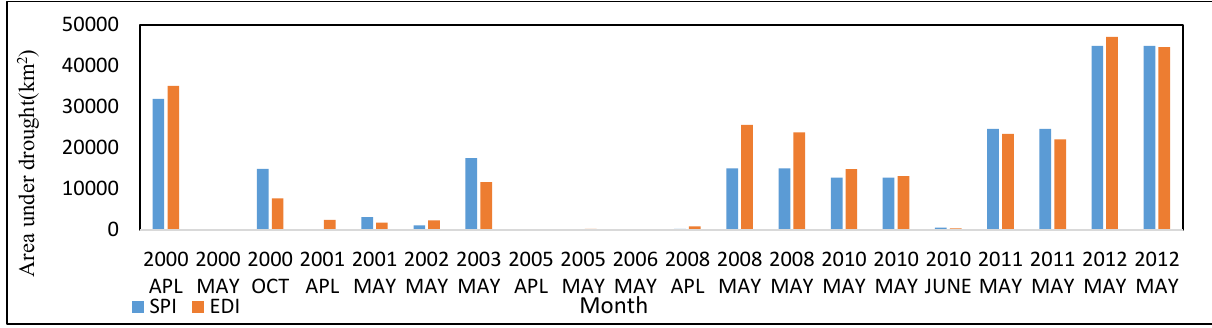
Figure 11.Area under drought as per SPI and EDI for Deccan Plateau